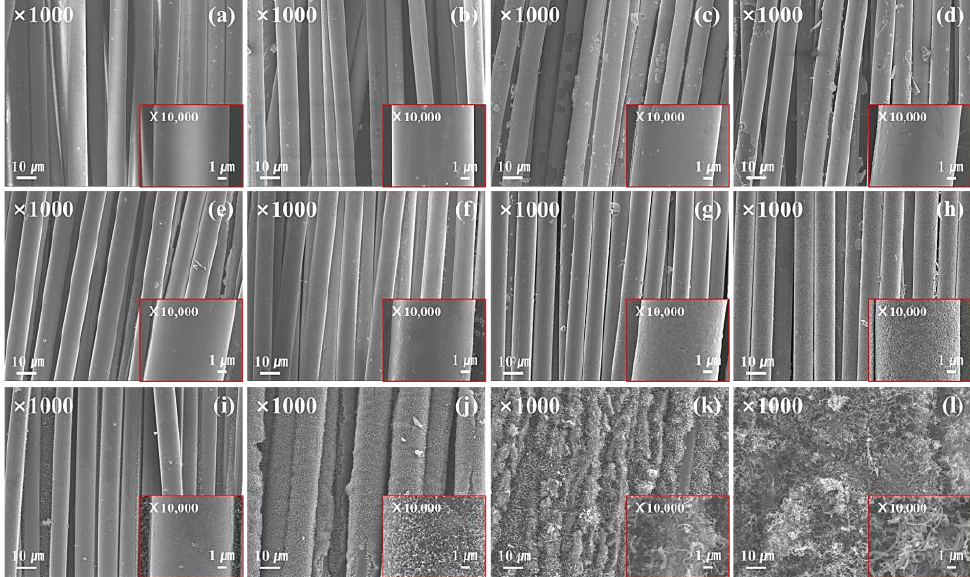
Figure 2. SEM images of the glass fiber with CNTs grown on the surface; Ni-P-plated glass fiber; ( a ) NGF-10, ( b ) NGF-30, ( c ) NGF-60, ( d ) NGF-120, ( e ) HNGF-10, post-heat-treated glass fiber after Ni-P plating; ( f ) HNGF-30, ( g ) HNGF-60, ( h ) HNGF-120, glass fiber with CNTs grown on the surface after post-heat treatment; ( i ) HNGF-CNTs-10, ( j ) HNGF-CNTs-30, ( k ) HNGF-CNTs-60, ( l ) HNGF-